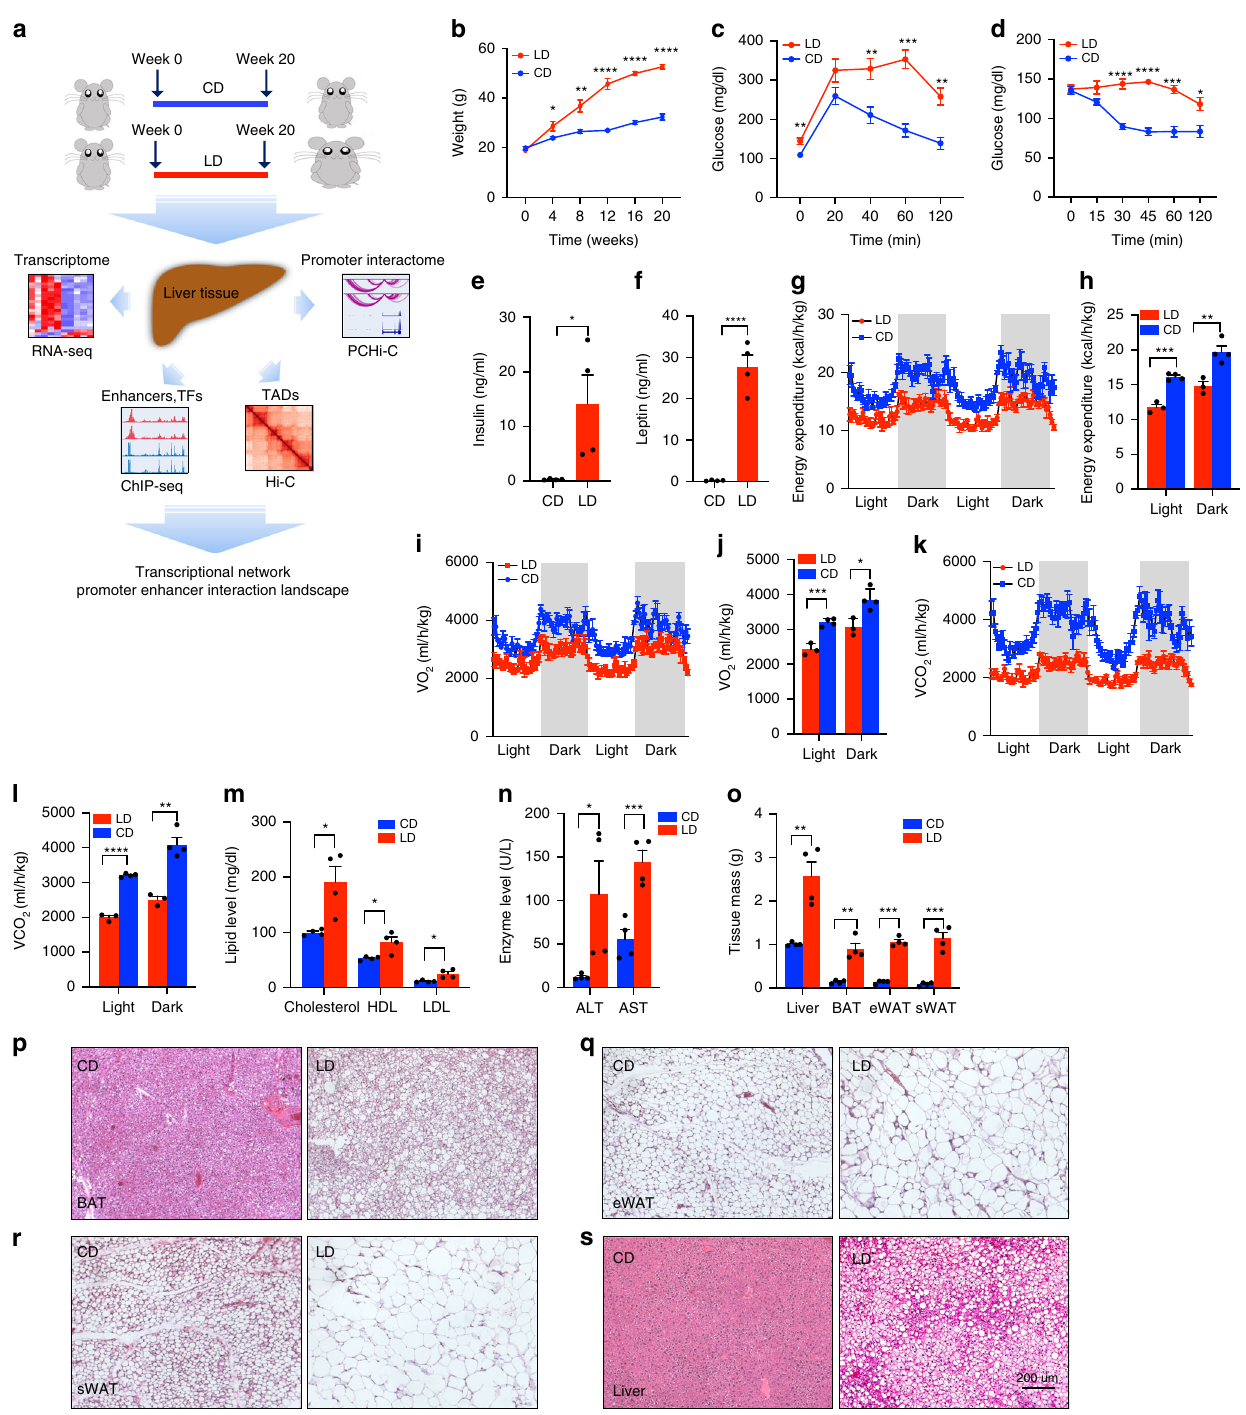
Fig. 1 Effects of diet on metabolic parameters. a Schematic overview of the study. b Body weight (mean and SEM) of study animals ( n = 5 per group) after 20 weeks of carbohydrate-rich diet (CD) or lipid-rich diet (LD). c , d IPGTT and IPITT tests in mice fed the LD or CD ( n = 5 per group). e , f Fasting plasma insulin and leptin level in mice fed the LD or CD ( n = 4 per group). g – l Metabolic cage analysis during light and dark phase of energy expenditure (EE), oxygen consumption rate (VO 2 ), carbon dioxide production (VCO 2 ) ( n = 3 – 4 per group). m , n Fasting plasma lipids and enzymes in mice fed the LD or CD. o Liver, brown adipose tissue (BAT), subcutaneous adipose tissue (sWAT), and epididymal adipose tissue (eWAT) mass in mice fed the LD or CD. p – s Hematoxylin and eosin (H&E) staining of adipose tissue and liver (×40 magni fi cation; scale bar indicates 200 μ m). Signi fi cance is indicated (two-tailed t test). ∗ p < 0.05, ∗∗ p < 0.01, ∗∗∗ p < 0.001. ∗∗∗∗ p <